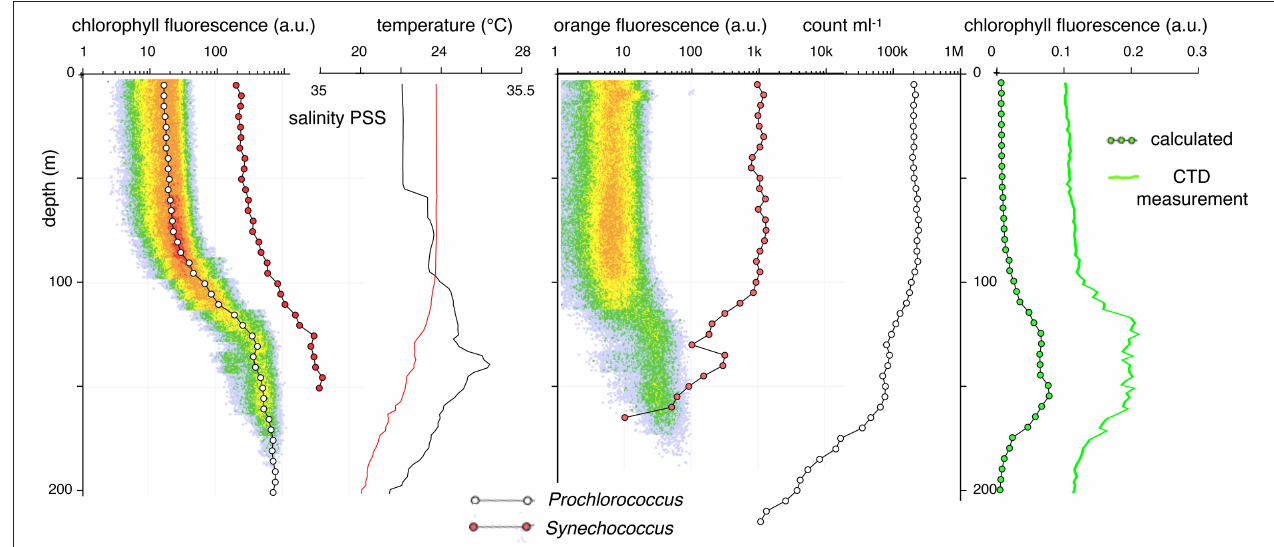
FIGURE 8 | A 5-m FCM phenotype depth profile at Station ALOHA on March 23, 2014, 9:00 HST. After a deep mixing event the water column has become stable and a slight temperature gradient has developed in the mixed zone. The top of the thermocline still shows signs of salinity and Prochlorococcus anomalies. As in the previous profiles, discontinuities in the Prochlorococcus FCM phenotype profiles correspond to a double peak in the CTD bulk chlorophyll fluorescence trace.